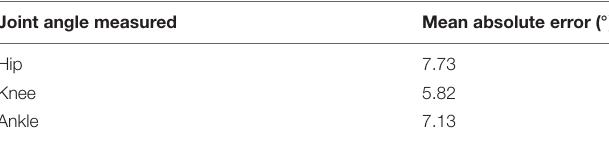
TABLE 1 | The error between normative data and the proposed system with default settings.